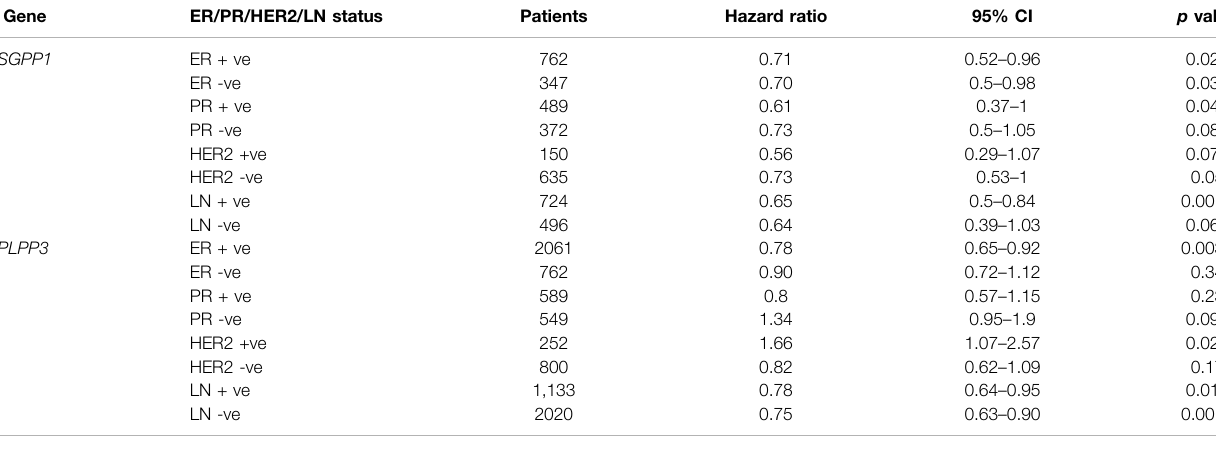
TABLE 3 | Correlation between mRNA expression of SGPP1 and PLPP3 with relapse-free survival in the breast cancer patients with ER, PR, HER2 and LN status. Gene